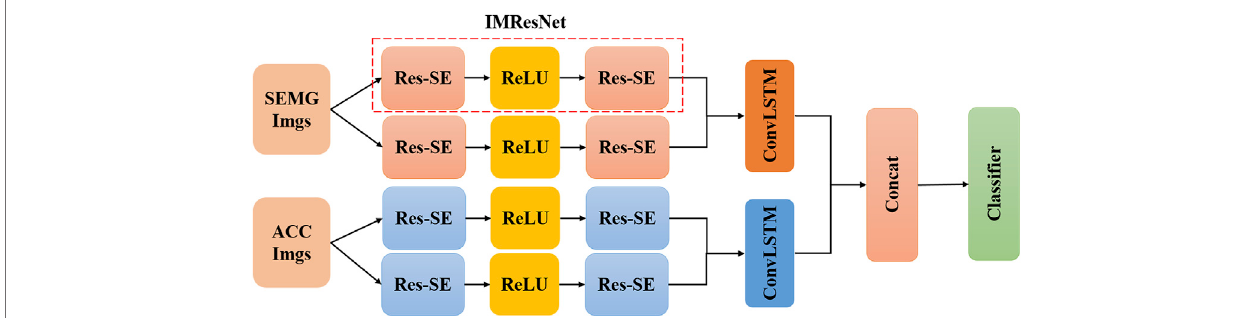
FIGURE 2 | The overall framework of the MResLSTM.